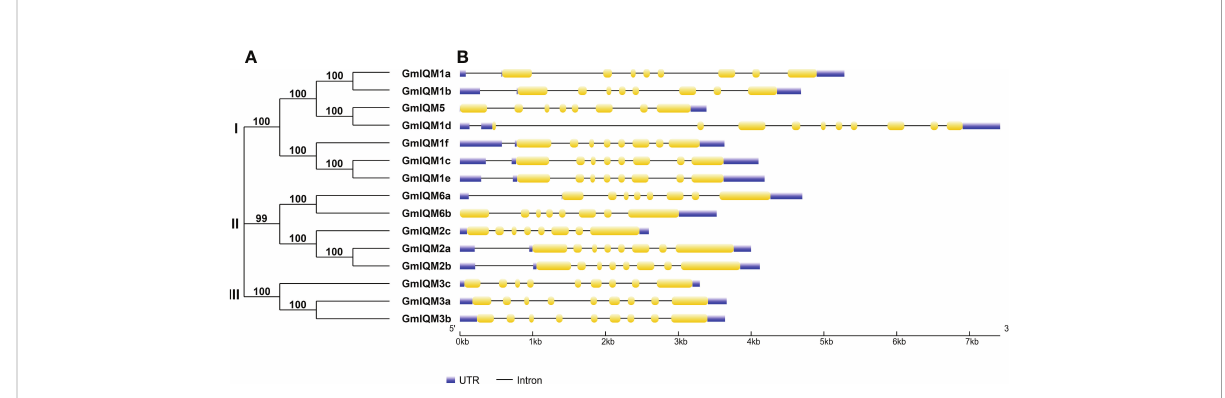
FIGURE 2 Phylogenetic relationships and gene structures of the GmIQM genes. (A) Unrooted phylogenetic tree of GmIQMs . The full-length amino acid sequences of 15 GmIQMs were aligned by ClustalW, and the unrooted phylogenetic tree was constructed using MEGA11 by the neighbor- joining method. The number of bootstrap values was 1000 replicates. (B) Exon/intron organization of soybean IQM genes. Yellow boxes represent exons, black lines represent introns, blue boxes represent Untranslated regions (UTRs). The sizes of exons and introns can be estimated using the scale at the